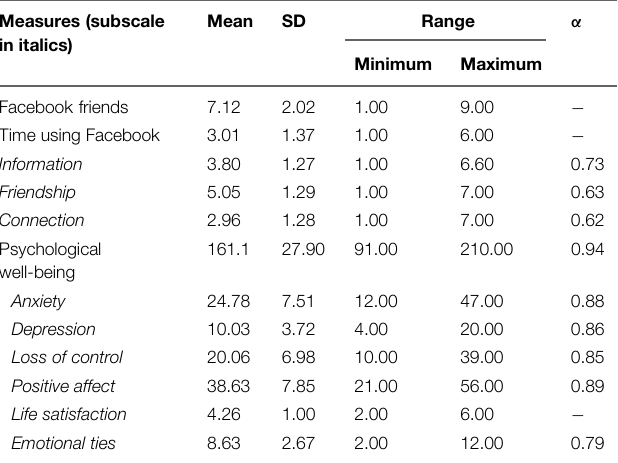
TABLE 2 | Mean, SD, and reliability index for study measures. Measures (subscale in